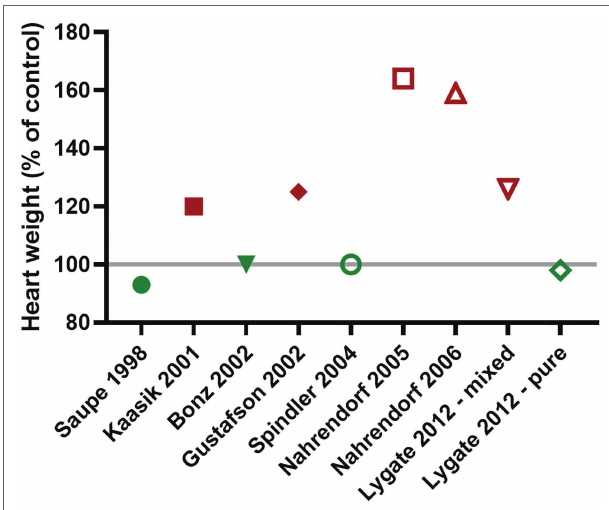
FIGURE 2 | The presence or absence of cardiac hypertrophy in CK double knockout mice (CK-dKO) has varied considerably over time and between laboratories, in large part, due to a mixed and changing genetic background. When finally bred onto a pure C57BL/6 J background, no cardiac hypertrophy was evident (Lygate et al., 2012a,b -